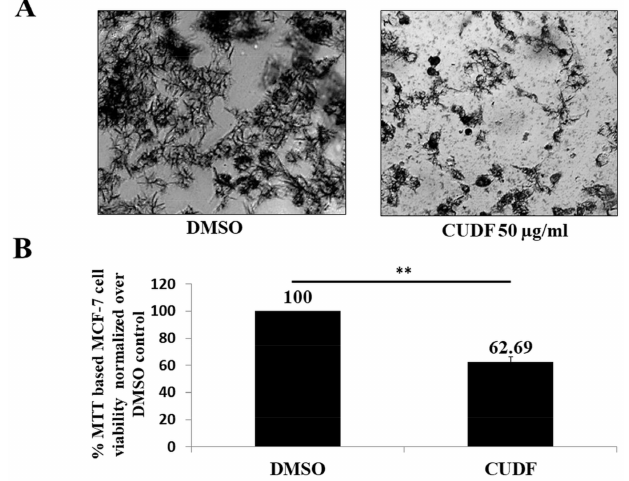
Figure 2. Cow urine DMSO fraction (CUDF) shows cytotoxicity to MCF-7 breast cancer cells. ( A ) MCF- 7 cancer cells were treated with DMSO and CUDF (50 µ g/mL) for 72 h. During the MTT assay, microscopic images of viable cells were captured, and ELISA-based measurements were performed. ( A ) Microscopic photographs captured at 100 × . ( B ) MCF-7 cancer cells were treated with DMSO and CUDF (50 µ g/mL) for 72 h. The value in terms of the percentage of cell viability normalized relative to the DMSO control was calculated based on the absorbance obtained in the MTT assay. ** Significantly different from the DMSO control at a p -value ≤